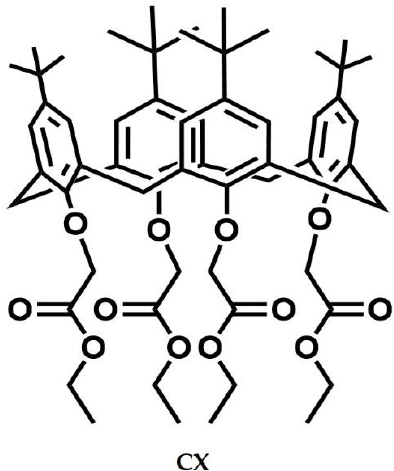
Figure 1. Molecular structure of the tetra(ethoxycarbonyl-methoxy)-4- tert -butylcalix[4]arene (CX).